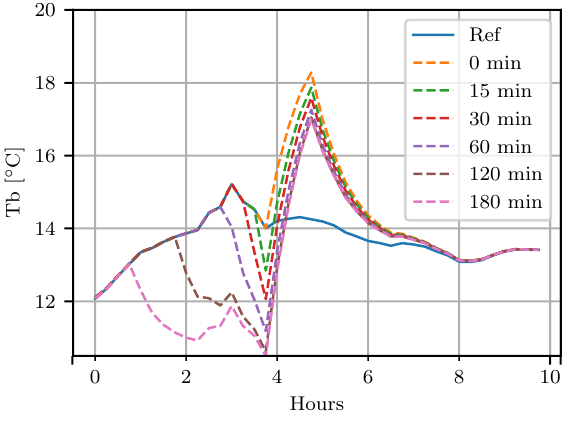
Figure 12. The effect of pre-cooling on the water basin temperature.